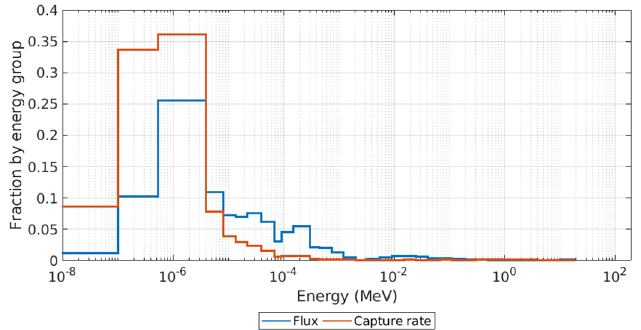
Fig. A2. Neutron spectrum and capture rate by group in the internal heat